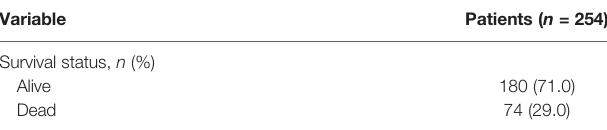
TABLE 1 | Clinicopathological and molecular characteristics of patients with stage II – III colorectal cancer